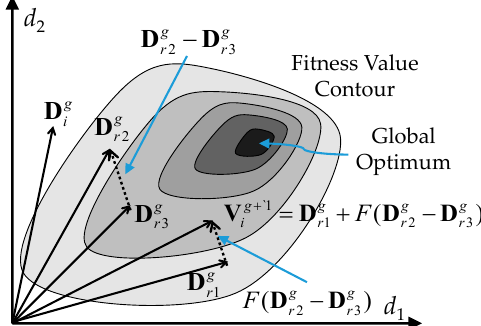
Figure 2. Example of a two-dimensional fitness contour showing the process for generating a mutant vector V g+ 1 i